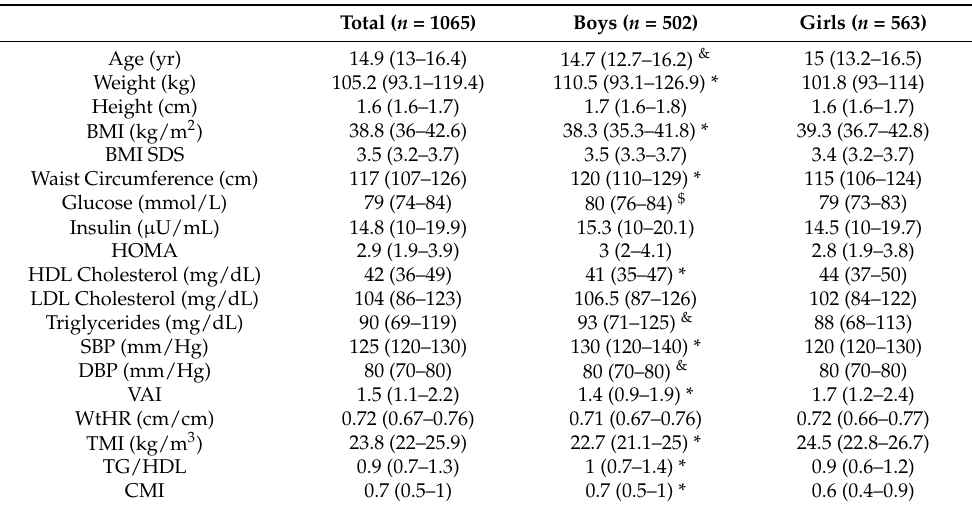
Table 1. Clinical and biochemical data in boys and girls. Data are expressed as median (interquartile